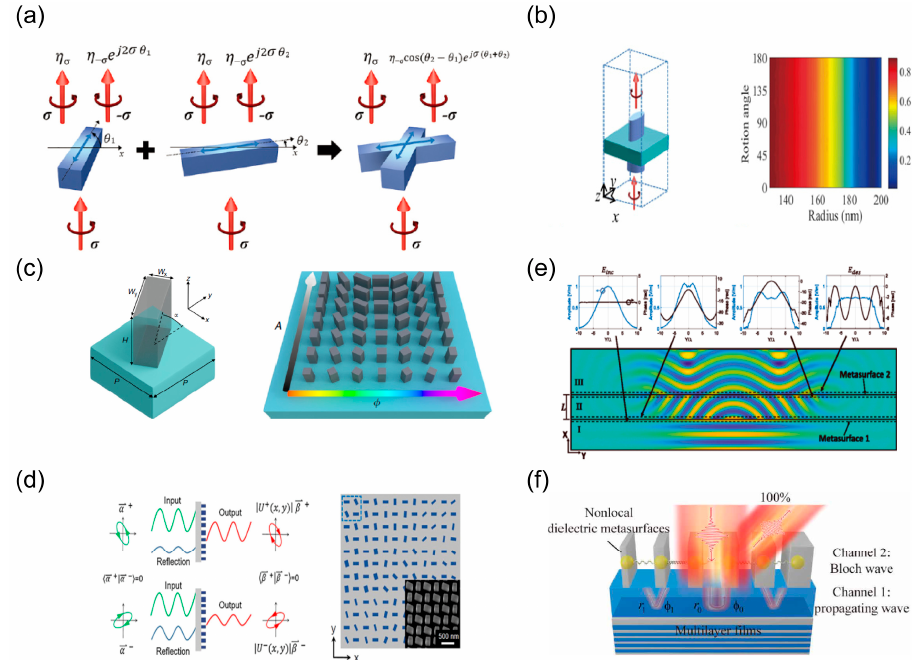
Figure 3. Amplitude control of metasurfaces. ( a ) Schematic of regulation mechanism with X-shaped meta-atoms [160]. ( b ) Amplitude control enhanced by using Fabry–Perot resonance of the sandwich configuration [161]. ( c ) Decoupling the amplitude and phase by controlling polarization conversion efficiency and geometrical degree of freedom of the birefringent meta-atoms [100]. ( d ) Interference meta-molecules used to impose two independent amplitude profiles on any pair of orthogonal states of polarization [162]. ( e ) Principle of double layers of non-local metasurfaces manipulating amplitude without loss [163]. ( f ) Schematic of all-dielectric quasi-three-dimensional non-local meta-grating